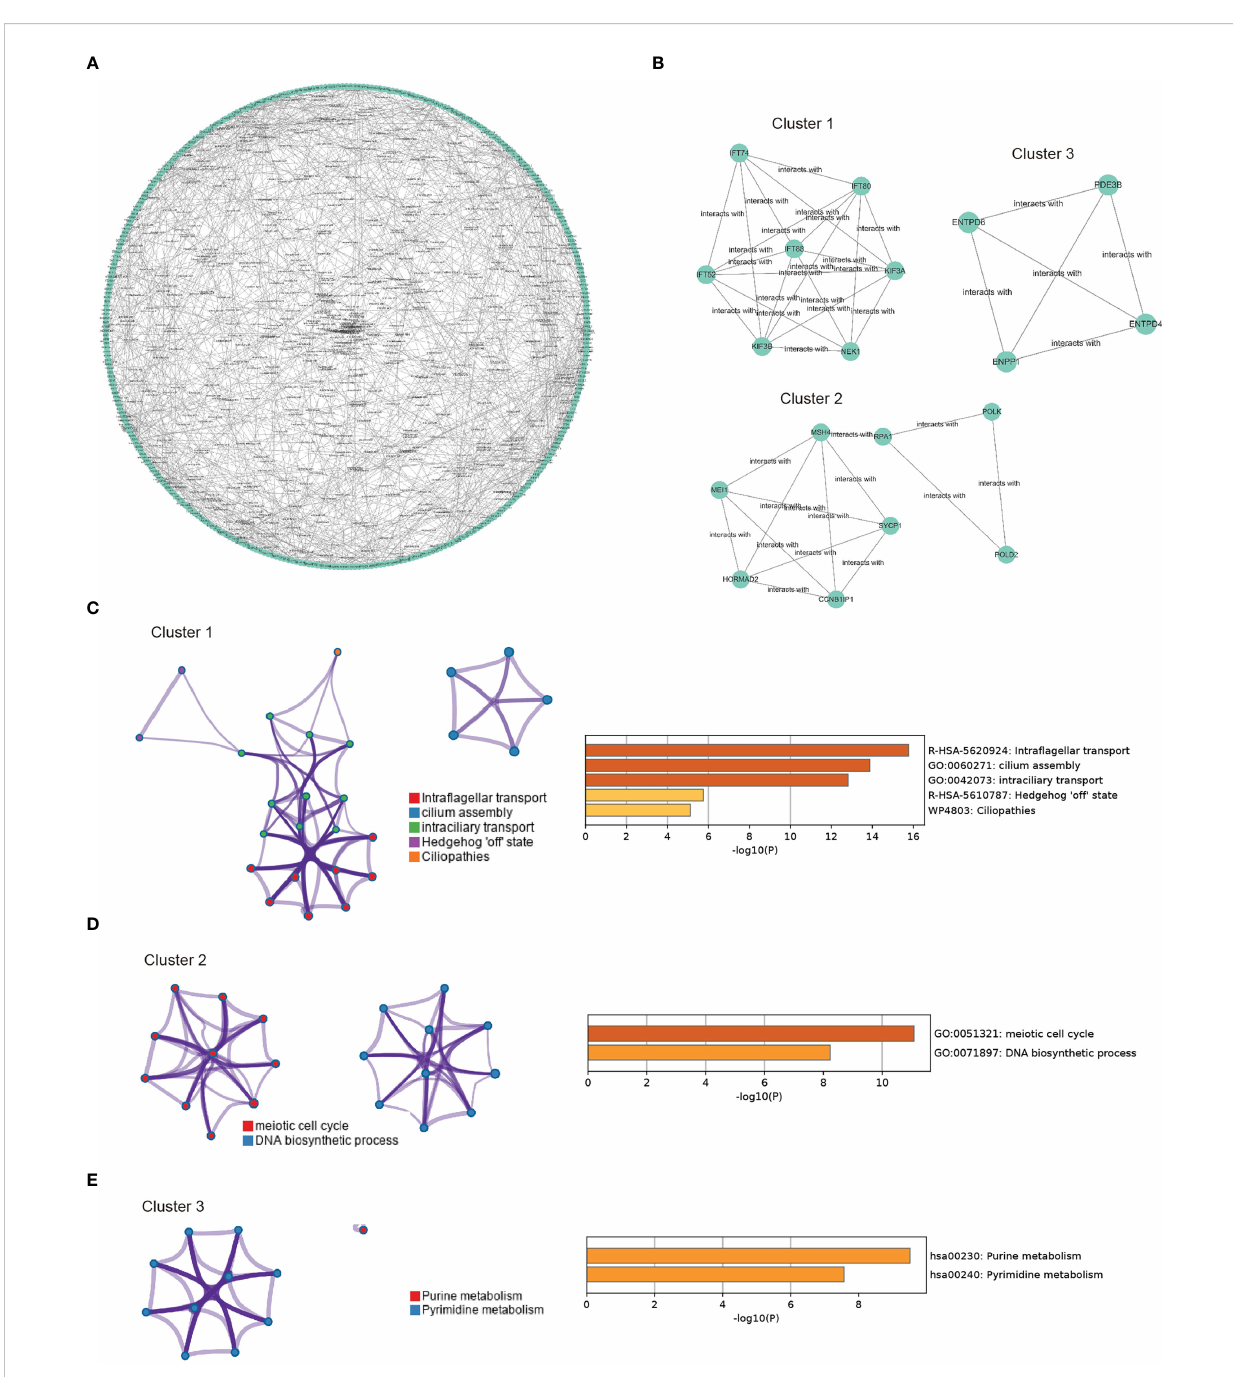
FIGURE 4 PPI network construction and module enrichment evaluation. (A) Protein-protein interaction network of CORGs using the STRING database. (B) Top three modules (Cluster 1-3) screened from PPI network using MCODE algorithm. (C) Go enriched-term interaction of the Cluster 1. (D) Go enriched-term interaction of the Cluster 2. (E) Go enriched-term interaction of the Cluster 3. Dots of the same colors indicate the same GO enriched-terms, and dots of size indicate the number of consensus genes in this GO term, the larger the number, the larger the size. PPI: protein- protein interaction; CORGs: COVID-19-related differentially expressed genes; GO: Gene